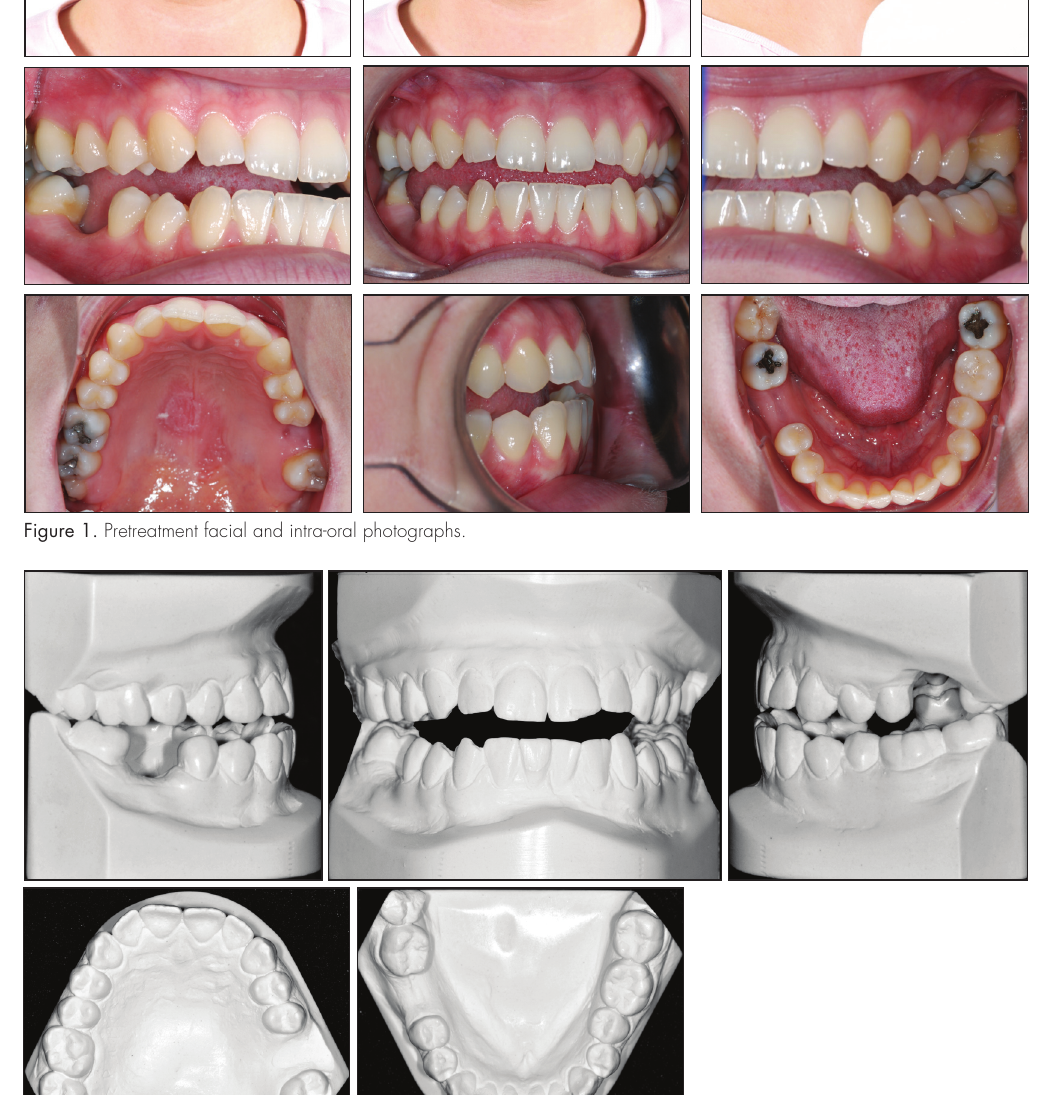
Figure 2. Photographs of pretreatment dental